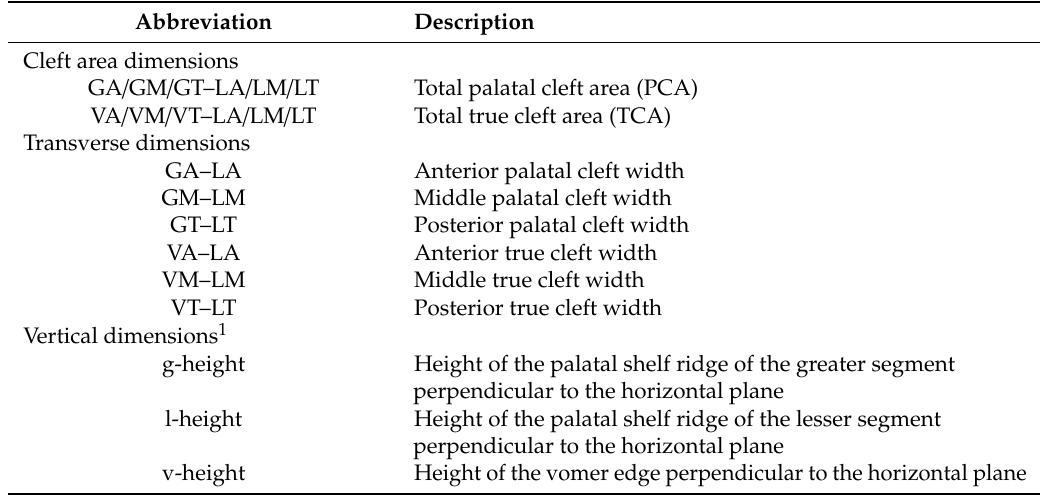
Table 2. Definitions of 3D landmark